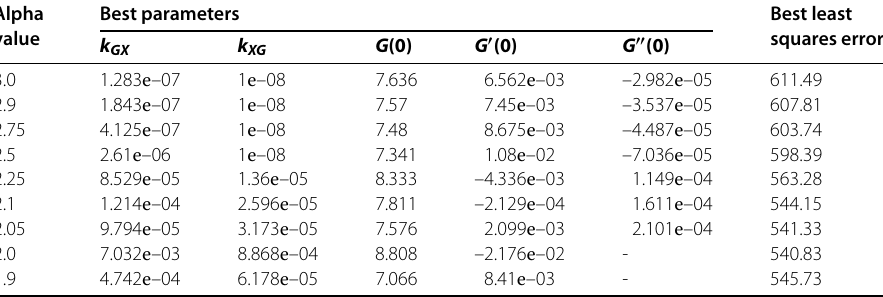
Table 6 Best least squares fits for fractional alpha model for subject 6 CGM